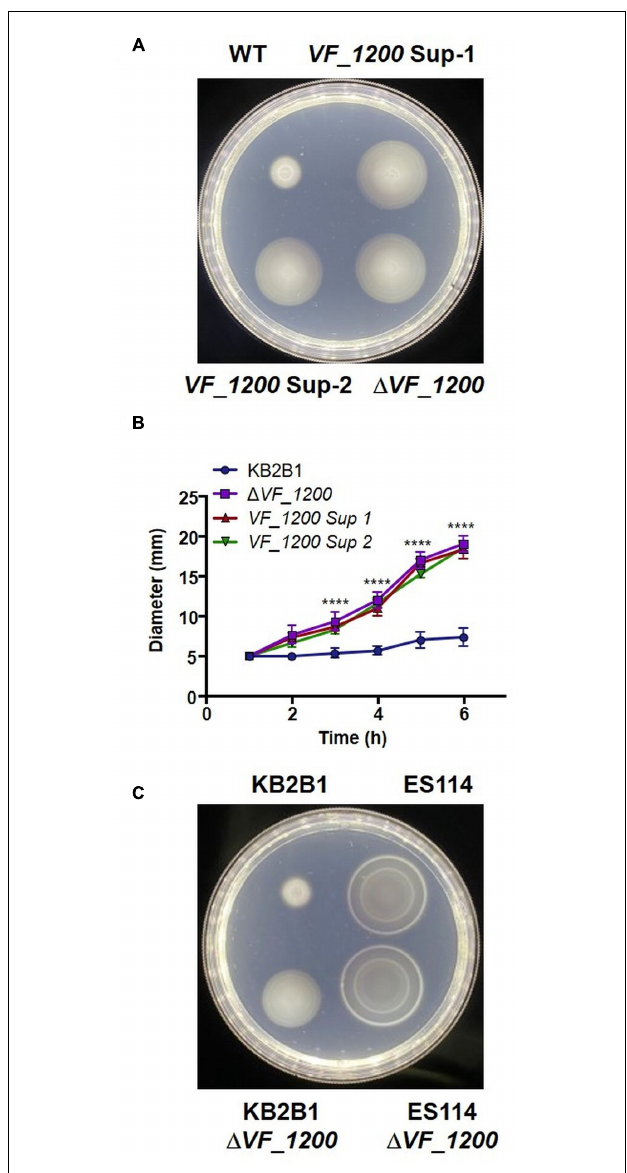
FIGURE 7 | Motility of VF_1200 mutants. (A,B) Migration on TBS-Mg 2 + soft agar of wild-type KB2B1 and its derivatives strains KV8962 [ VF_1200 suppressor mutant-1 ( VF_1200 -Sup-1)], KV8965 [ VF_1200 suppressor mutant-2 ( VF_1200 -Sup-2)], and KV8973 ( (cid:49) VF_1200 ). (A) Captured at 6 h post-inoculation. Statistics were done via two-way ANOVA. **** p < 0.0001. (C) Migration on TBS-Mg 2 + soft agar of wild-type KB2B1, ES114, and corresponding (cid:49) VF_1200 mutants (KV8973 and KV8932). (C) Taken at 5 h post-inoculation.